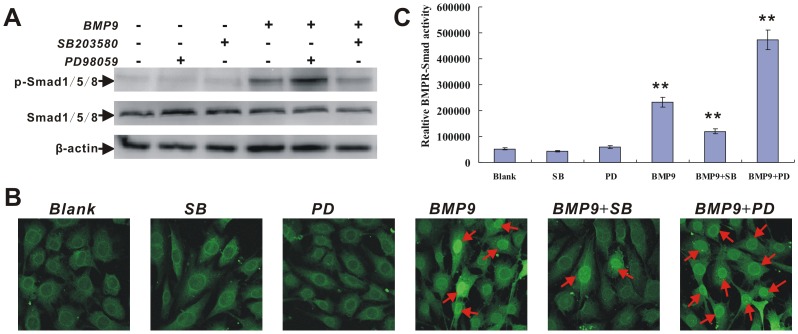
Inhibition of p38 and ERK1/2 activity leads to opposing effects on BMP9-indcued classical Smads signaling in MPCs.(A) Western blotting analysis of SB203580 and PD98059 on BMP9-induced Smad1/5/8 phosphorylation. Subconfluent C3H10T1/2 cells were pretreated with SB203580 (25 mM) or PD98059 (10 mM), and then treated with BMP9-CM. At 30 mins post BMP9-CM treatment, total amount and phosphorylated forms of Smad1/5/8 was analyzed by western blotting. (B) Immunofluorescence staining analysis of SB203580 and PD98059 on BMP9-induced nuclear translocation of Smad 1/5/8. Subconfluent C3H10T1/2 cells were pretreated with SB203580 (25 mM) or PD98059 (10 mM), and then treated with BMP9-CM. At 2 hrs post BMP9-CM treatment, nuclear translocation of Smad 1/5/8 by Immunofluenrescence staining. Magnification, ×200 (C) Luciferase reporter analysis of SB203580 and PD98059 on BMP9-induced Smad1/5/8 transcriptional activity. C3H10T1/2 cells were transfected with p12xSBE-luc. Next, cells were pretreated with SB203580 (25 mM) or PD98059 (10 mM), and then treated with BMP9-CM. At 36 hrs, cells were lyzed for luciferase activity assay. Luciferase activity was normalized by total cellular protein concentrations among the samples. “**”, p<0.01 (vs. control groups).